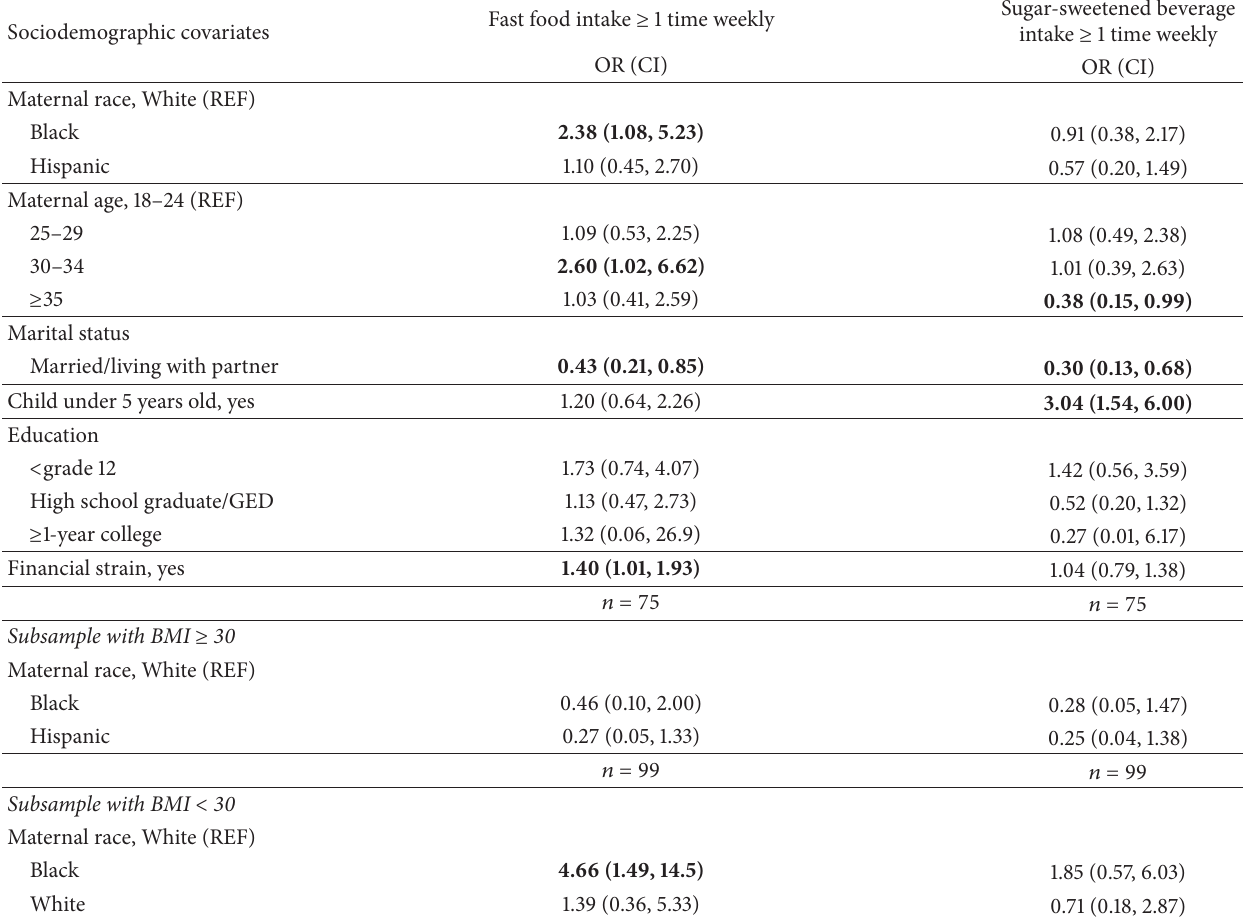
Table 2: Adjusted odds of fast food and sugar-sweetened beverage